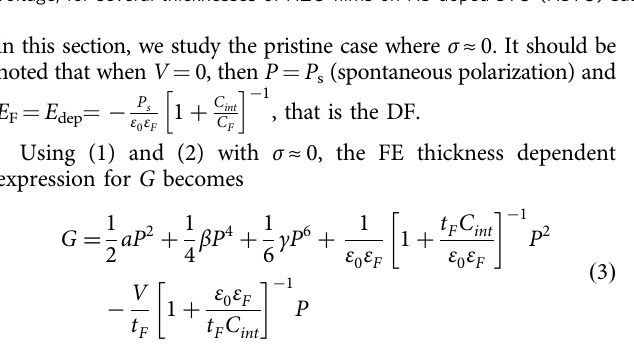
Fig. 2 Evolution of ferroelectric hysteresis of Hf 0.5 Zr 0.5 O 2 with Hf 0.5 Zr 0.5 O 2 thickness scaling. a – h Polarization and Displacement current as a function of applied voltage, for several thicknesses of Hf 0.5 Zr 0.5 O 2 (HZO) fi lms on Ge substrate. i – p Polarization and Displacement current as a function of applied voltage, for several thicknesses of HZO fi lms on Nb-doped STO (NSTO)